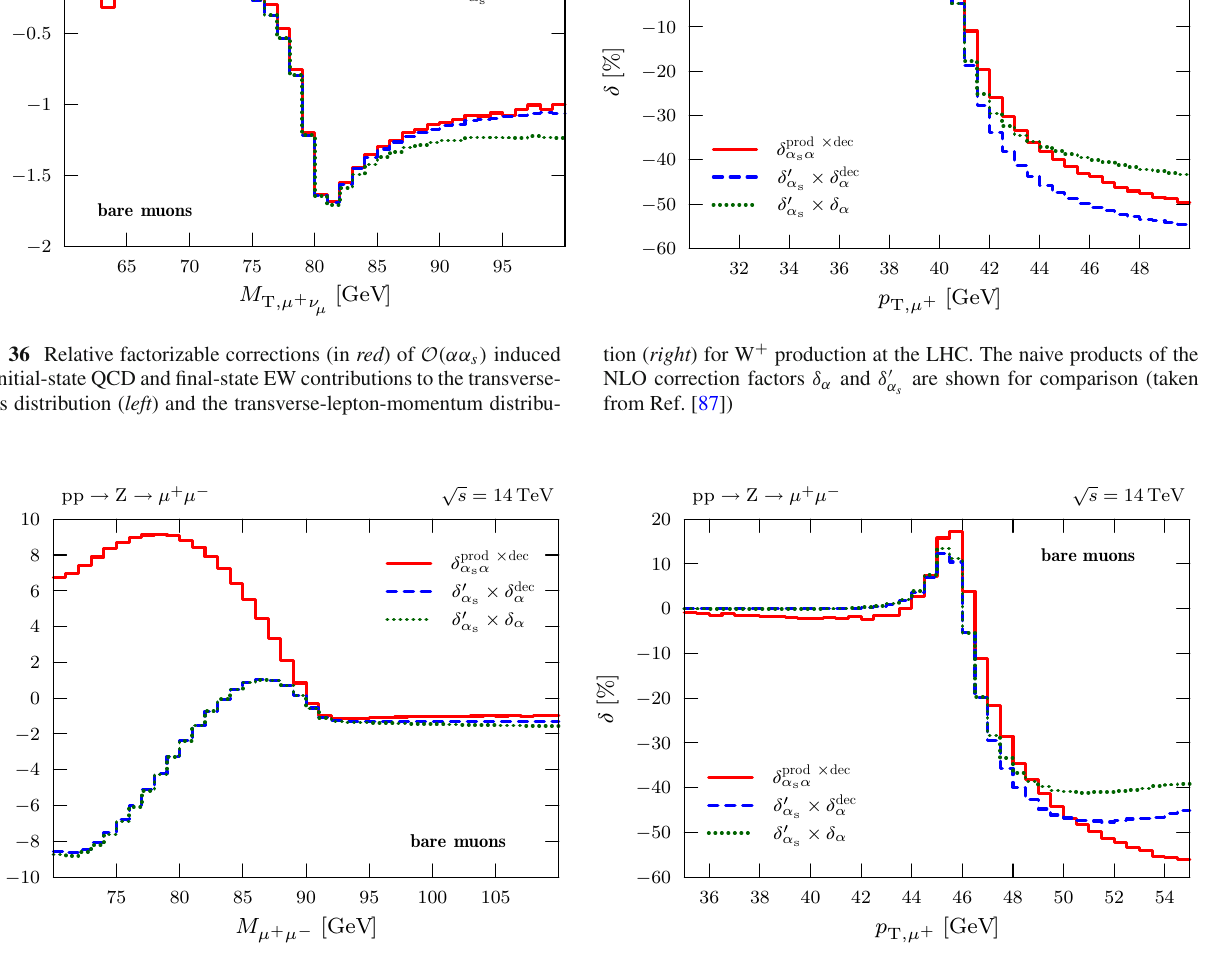
distribution ( right ) for Z production at the LHC. The naive products of the NLO correction factors δ (cid:10) α and δ α are shown for comparison s (taken from Ref.